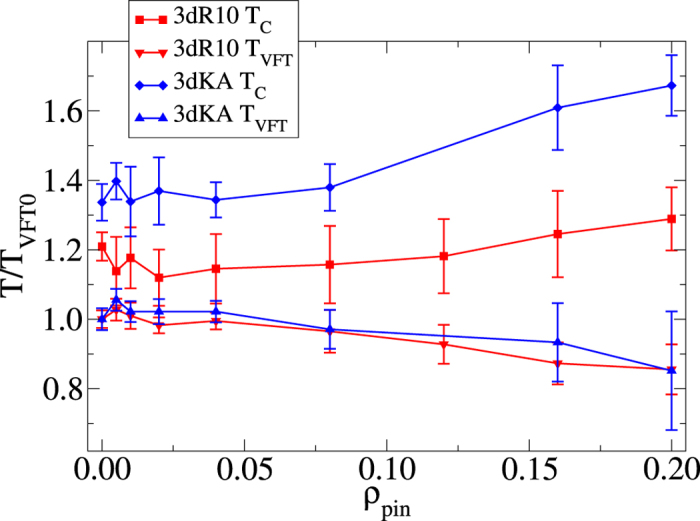
Phase diagram—Variation of the MCT-transition temperature TC and the VFT-divergence temperature TVFT with ρpin for the 3dKA and the 3dR10 models. For comparison all temperatures are scaled by the VFT-divergence temperature for the unpinned system, TVFT0. The lines join successive data points.